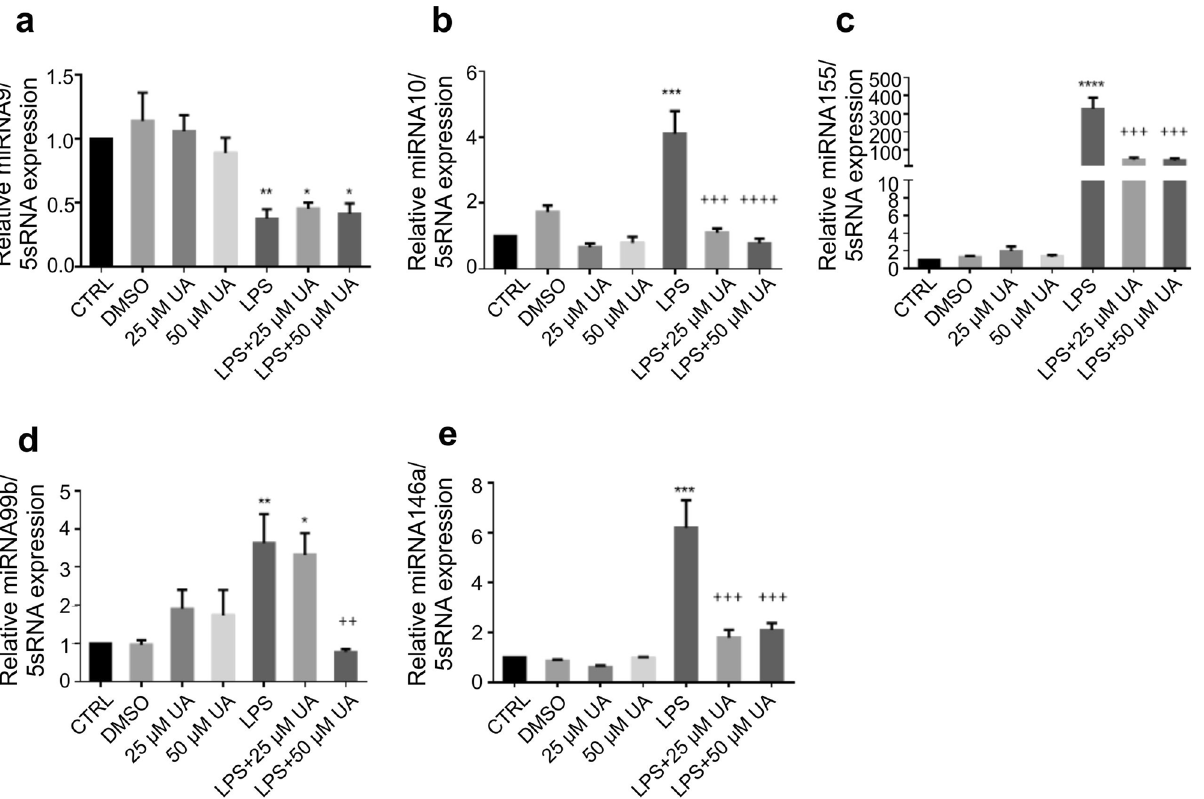
Figure 1. Urolithin A suppressed the inflammatory miRNA expression in LPS-stimulated murine BMDMs. Murine BMDMs were stimulated by 1 µg/ml of LPS in the presence or absence of UA (25 µM or 50 µM). The expression of miR-9 ( a ), miR-10 ( b ), miR-99b ( c ), miR.146a ( d ) and miR-155 ( e ) over 5S rRNA was evaluated in stimulated BMDMs after 72 h. The unstimulated and untreated BMDMs were used as control. BMDMs treated with DMSO were used as negative control. Arithmetic means ± SEM from seven independent experiments are depicted. One way ANOVA was used and *( p < 0.05), **( P 0.01), ***( p < 0.001), and ****( p < 0.0001) indicate statistically significant differences compared to control. ++( P 0.01), +++( p < 0.001), and ++++ ( p < 0.0001) indicate statistically significant differences compared to LPS. Abbreviations: DMSO, dimethyl sulfoxide; UA, urolithin A; LPS, lipopolysaccharides; miR, micro